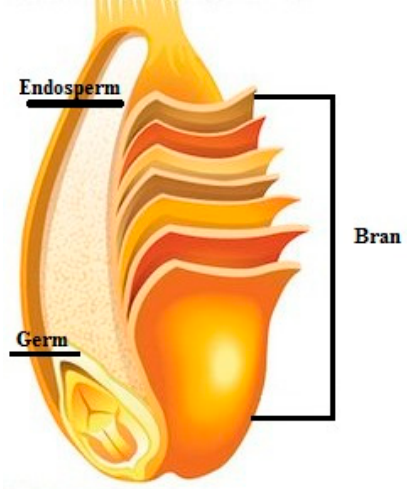
Figure 1. Whole-wheat grain main sections (adapted from Reference [37]).